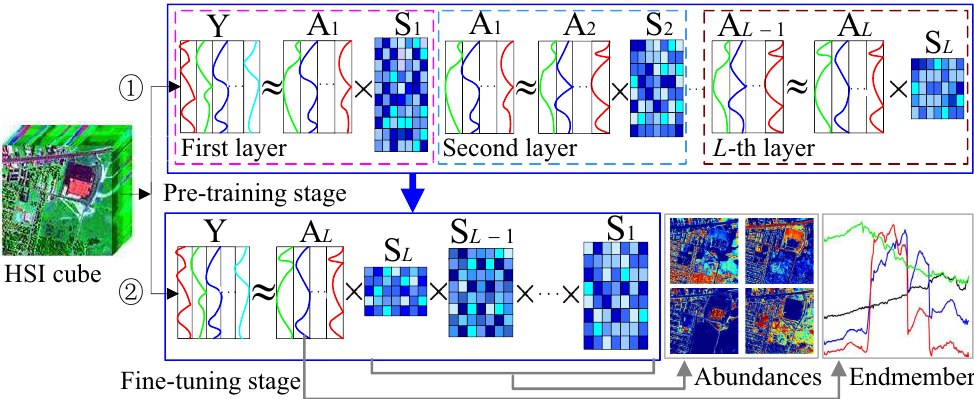
Figure 1. Illustration of the proposed model of deep nonnegative dictionary factorization that includes two parts: pre-training and fine-tuning stages. By the pre-training stage, we aim to learn a set